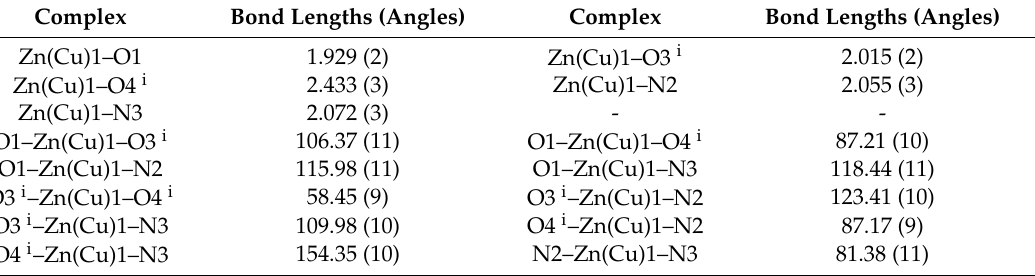
Table 2. Selected bond lengths (Å) and angles ( ◦ ) for